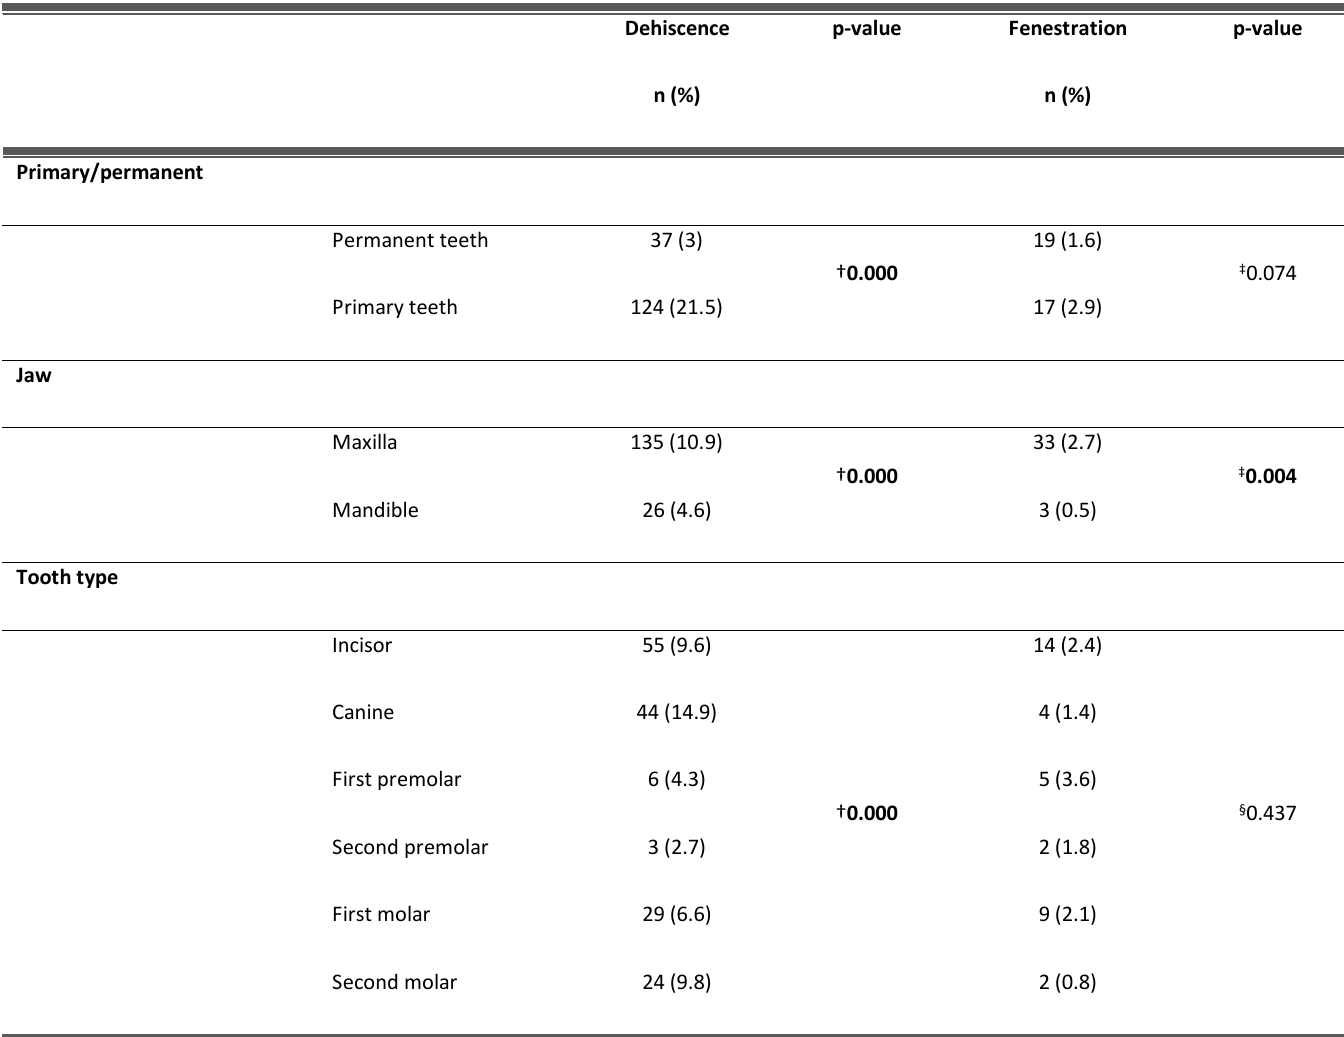
Table 4 . Tooth and jaw relations with dehiscence and